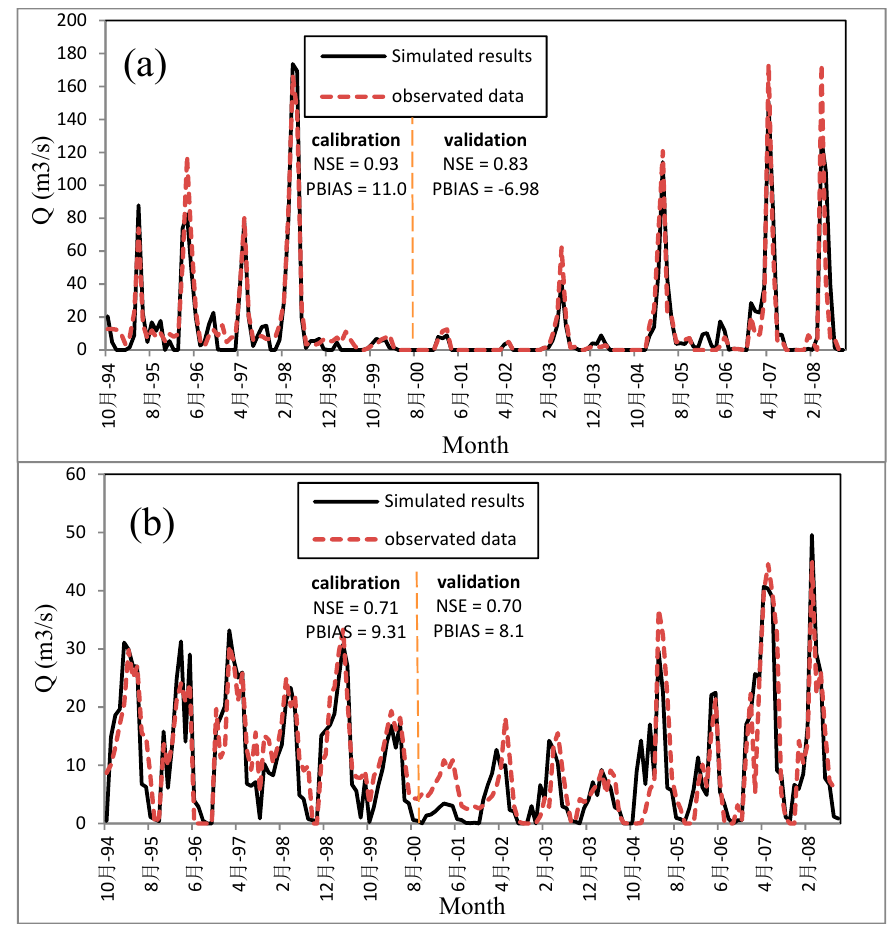
Figure 6. Simulation results and observation data for the calibration and validation period. The Nash–Sutcliffe model Efficiency (NSE) and PBIAS were used to evaluate the model’s predictive power for the 14-year streamflow of Jarigeh station ( a ) and Shirdel-Gelmir-Shomare1 station ( b ). Table 4. General performance rating the stream flow for PBIAS and Nash–Sutcliffe for a monthly time step [66].